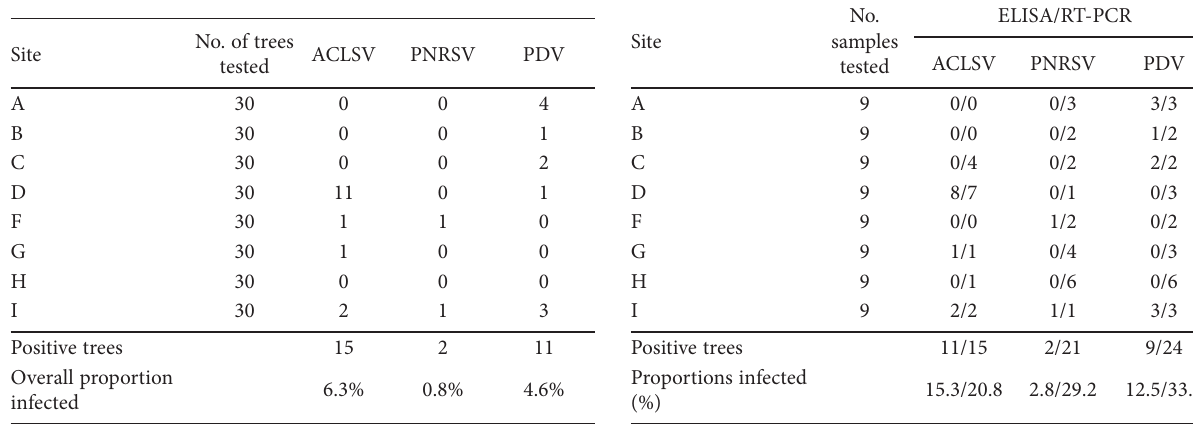
Table 2. Summary of ELISA results for ACLSV, PNRSV, and PDV on 30 randomly selected samples collected in 2018 from commer- cial cherry orchards in South Tyrol.